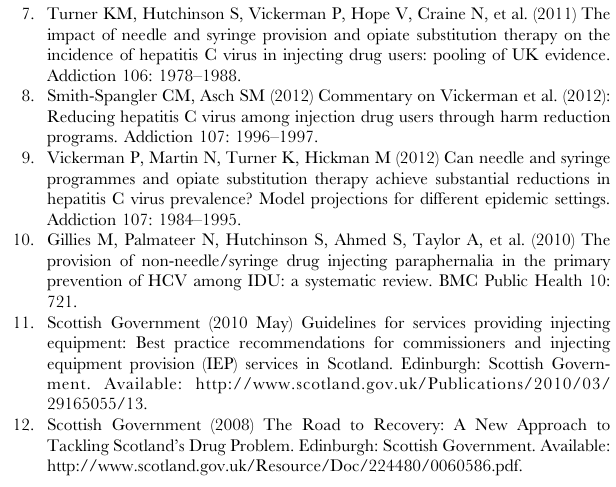
Table S2 Data used to calculate IEP coverage (based on service provision data). N/S = needles/syringes; PWID= people who inject drugs. a Data correspond to financial years, i.e. Table S3 Univariable and multivariable models of the association between needle/syringe coverage and shar- ing needles/syringes (in the last 6 months), including covariates a . N/S = needles/syringes. a Models are restricted to those who reported injecting in the last six months. b Excessive is defined as . 14 units/week for women and . 21 units/week for men. Table S4 Univariable and multivariable models of the association between spoon coverage and sharing spoons (in the last 6 months), including covariates a . a Models are restricted to those who reported injecting in the last six months. b Excessive is defined as . 14 units/week for women and . 21 units/week for men. Table S5 Univariable and multivariable models of the association between filter coverage and sharing filters (in the last 6 months), including covariates a . a Models are restricted to those who reported injecting in the last six months. b Excessive is defined as . 14 units/week for women and . 21 units/week for men. Table S6 Univariable and multivariable models of the association between OST and injecting daily or more frequently, including covariates a . a Models exclude individ- uals who reported not currently being on OST and also not injecting in the last six months. Table S7 Univariable and multivariable models of the association between frequency of injecting (in the last 6 months) and recent HCV infection a . a Models exclude individuals who reported not currently being on OST and also not injecting in the last six months. b Excessive is defined as . 14 units/week for women and . 21 units/week for men.